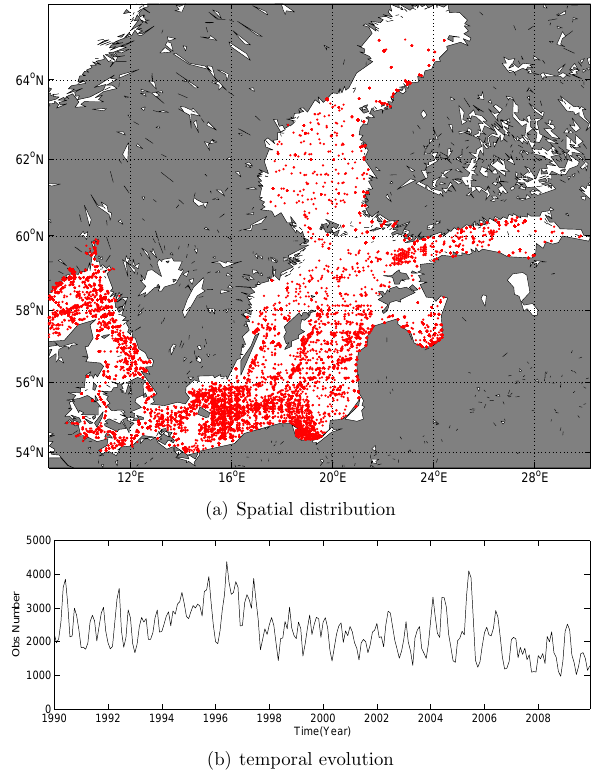
Fig. 1. The (a) spatial locations and (b) actual number of records Figure 1: The (a) spatial locations and (b) actual number of records of the of the T/S profiles assimilated into the model for each month from T/S profiles assimilated into the model for each month from 1990 to 2009. 1990 to